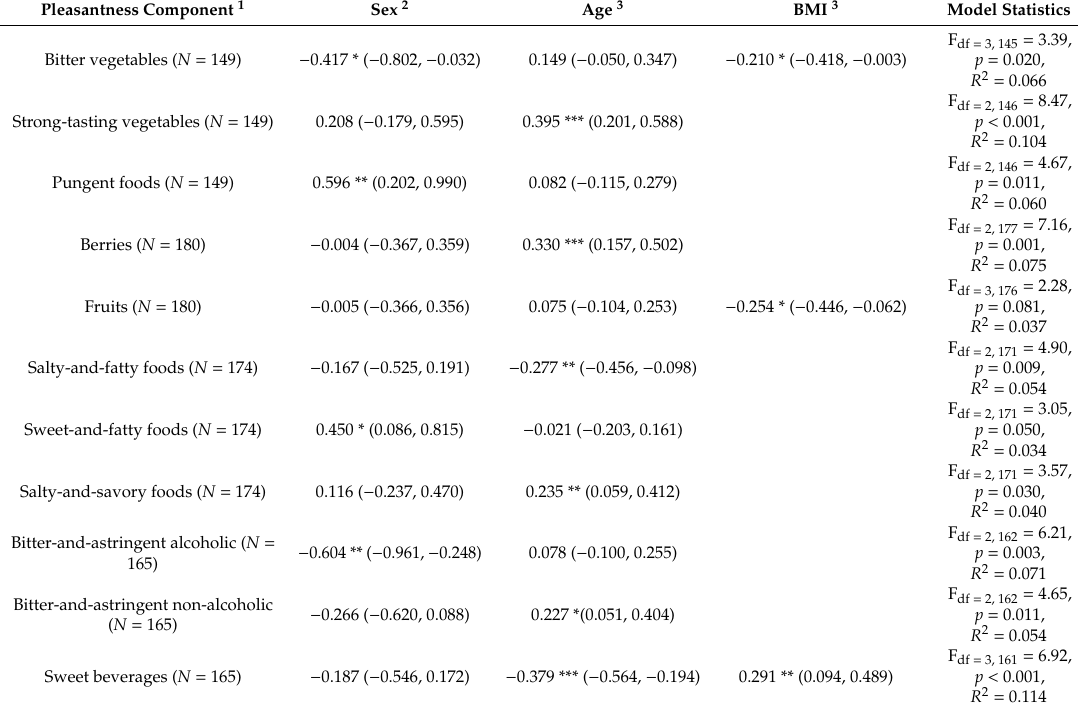
Table 5. The results of hierarchical multivariate linear regression, food pleasantness components as dependent variables: unstandardized β coe ffi cients (95% confidence intervals) and model